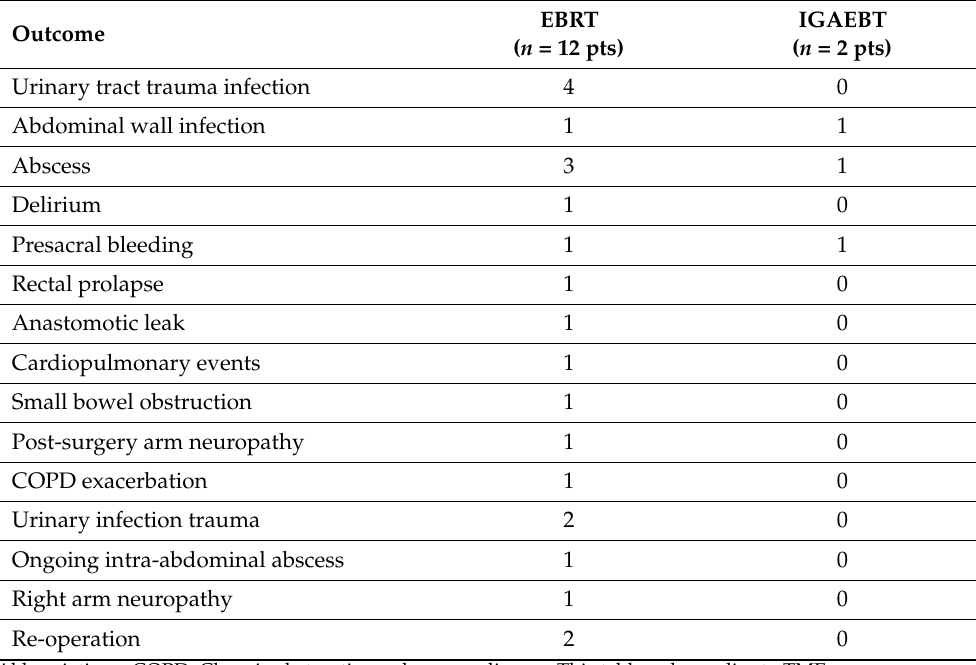
Table 3. Acute surgery-related toxicity outcomes by trial arm among patients who received surgery (n corresponds to number of